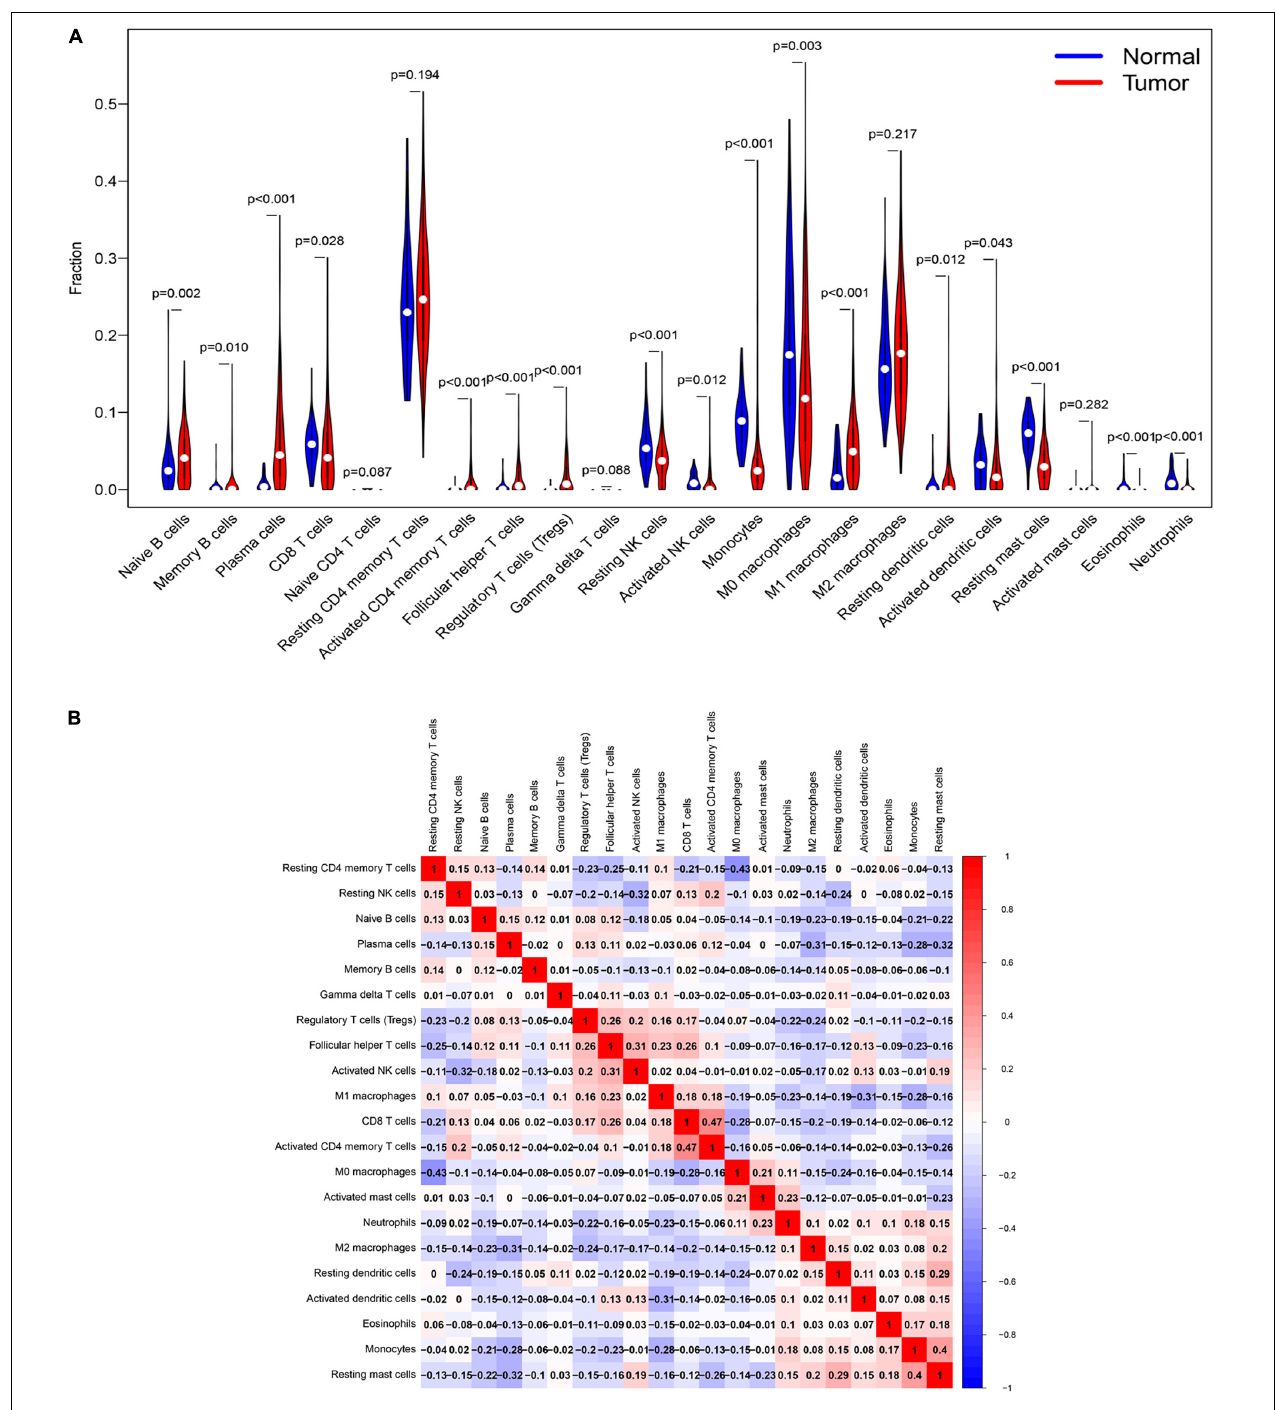
FIGURE 4 | The immune signature of tumor infiltrating immune cells (TILs) in LUAD. (A) The proportions of TILs among different LUAD samples with a P -value < 0.05. (B) The correlation index among TILs in LUAD. The red color and blue color represent positive and negative correlation, respectively. The depth of color represents the degree of correlation